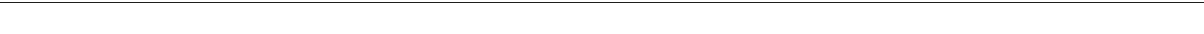
Fig. 3 Comparing RGN-induced gene targeting based on standard and in trans paired nicking in human PSCs. a Quanti fi cation of genetically modi fi ed PSCs by fl ow cytometry. Cultures of iPSCs (A, B, and E) and ESCs (C and D) were exposed to AAVS1 -speci fi c cleaving Cas9:gRNA S1 (standard) or nicking Cas9 D10A :gRNA S1 (Nick 2 ) complexes mixed with RGN-resistant or RGN-susceptible donor constructs, respectively, encoding either EGFP or Puro R .T2A. EGFP. The frequencies of gene-modi fi ed PSCs were determined by fl ow cytometric quanti fi cation of EGFP + and TRA-1-81 + dually labeled cells. b Representative fl ow cytometry dot plots corresponding to RGN-induced gene targeting experiments in PSCs. c Detection of gene-modi fi ed PSCs by colony-formation assays. ESCs ( top ) and iPSCs ( bottom ) were co-transfected with the indicated plasmids. After puromycin selection, alkaline phosphatase staining identi fi ed genetically modi fi ed PSC colonies. d RGN-induced gene targeting frequencies at AAVS1 in iPSCs. Junction PCR analyses of puromycin- resistant colonies from iPSC cultures initially co-transfected with pDonor.EP S1 and pCas9.gRNA S1 (standard) or with pDonor.EP S1.TS and pCas9 D10A .gRNA S1 (Nick 2 ). The respective PCR screening data are presented in Supplementary Fig. 13. e Differentiation potential of gene-edited PSCs. ESC and iPSC lines were targeted at AAVS1 by in trans paired nicking. Cell types characteristic of ectoderm, endoderm, and mesoderm were identi fi ed by confocal immuno fl uorescence microscopy for TUBB3, AFP, and CD31, respectively. f Characterization of indel footprints in iPSCs subjected to standard vs. in trans paired nicking. Nucleotide sequencing of AAVS1 target alleles in randomly selected iPSC clones ( n = 68) genetically modi fi ed by DSB-dependent and in trans paired nicking methodologies (Standard and Nick 2 , respectively). Indel footprints were exclusively identi fi ed in iPSCs subjected to the standard gene targeting approach (15/28). The gRNA S1 target site is indicated underneath the sequence reads. Open box PAM; vertical dashed line position of expected RGN-induced phosphodiester bond cleavage; Ctrl reference wild-type nucleotide sequence from unedited